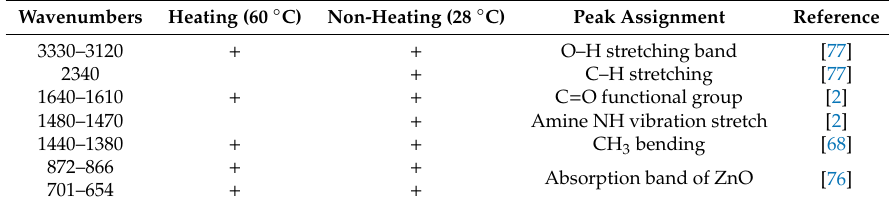
Table 1. Assignment of different peaks in the FTIR spectra of ZnO NPs prepared under heating (60 °C) and non-heating (28 °C) conditions.